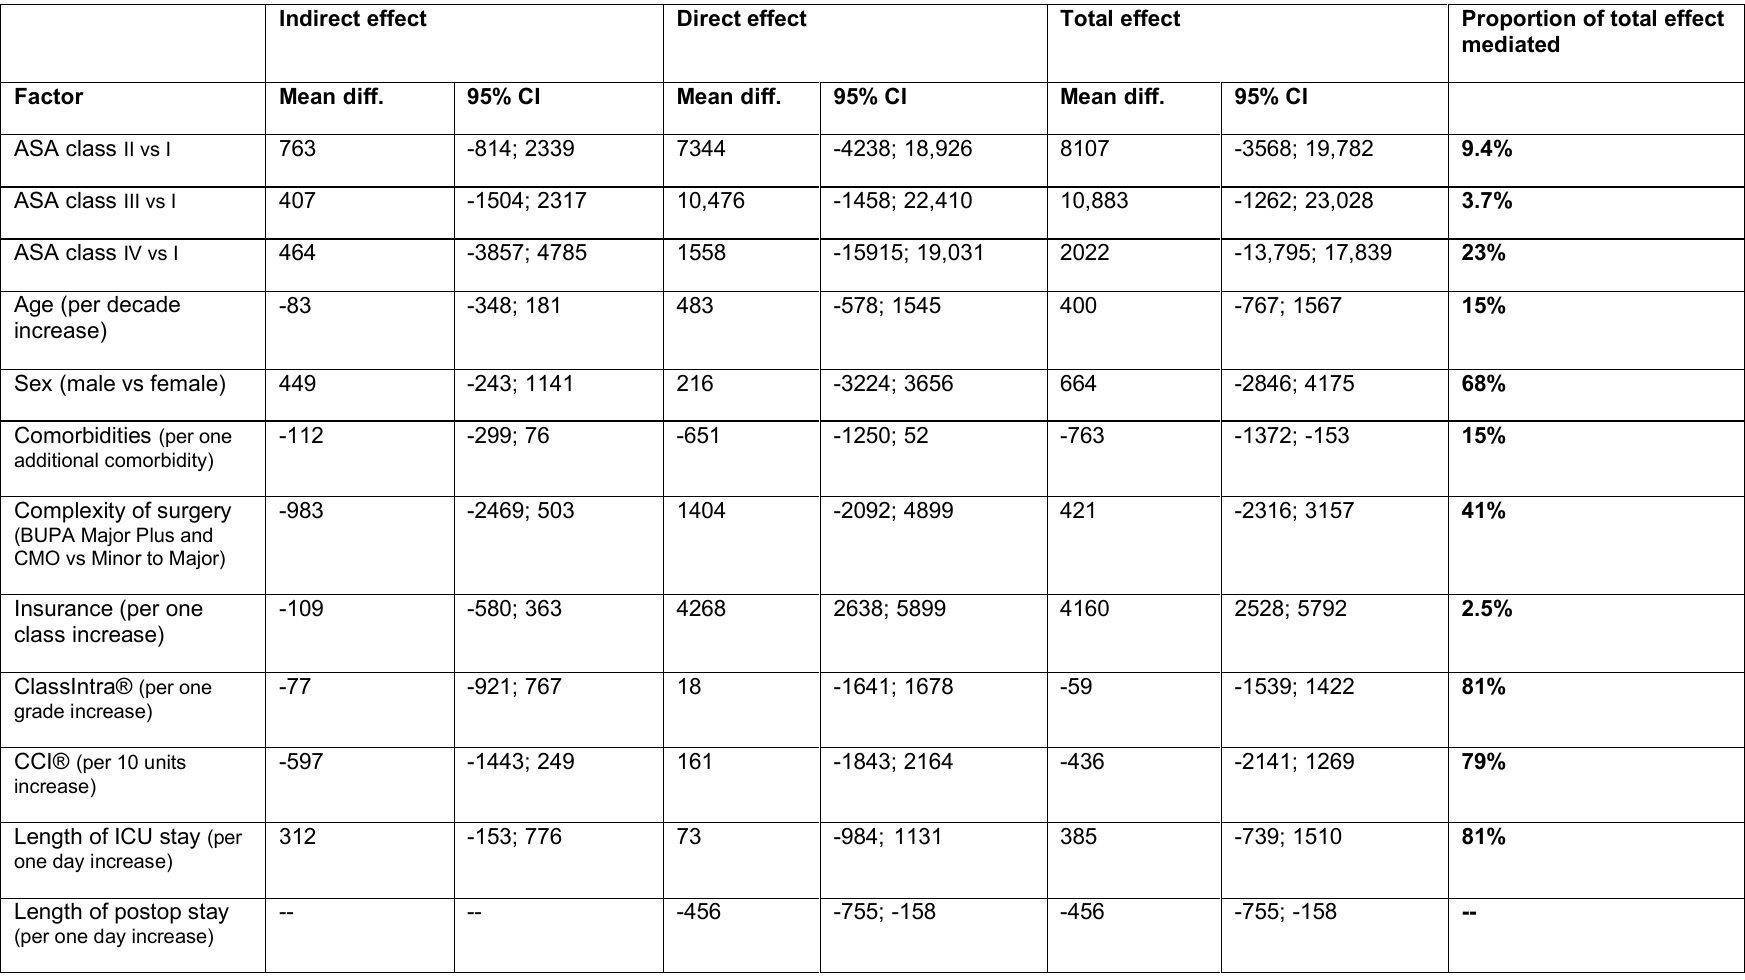
Table 5: Reimbursement model including all patients (in Euros) Indirect, direct and total effects on reimbursement. Coefficients are mean differences in reimbursement; all patients were included(n=320), and age and sex were considered as additional covariates. R-squared